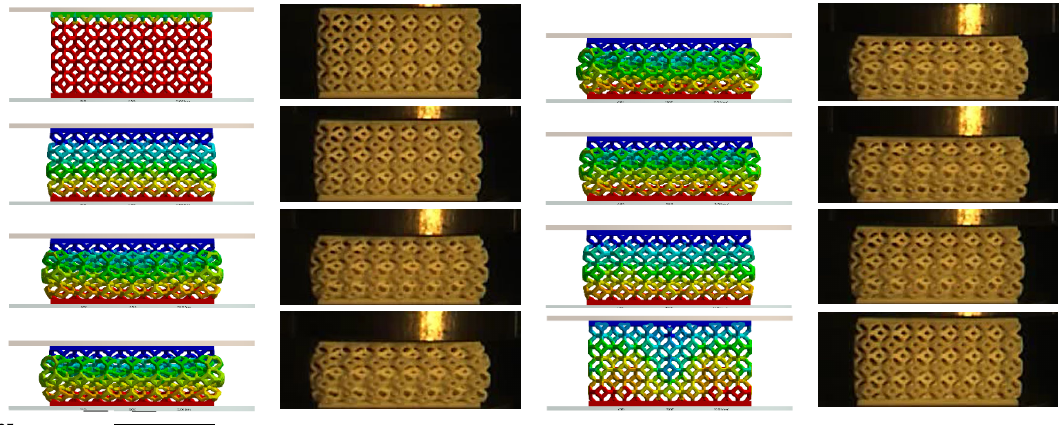
Figure 9. Impact force–displacement curve comparison for non ‐ graded lattice.